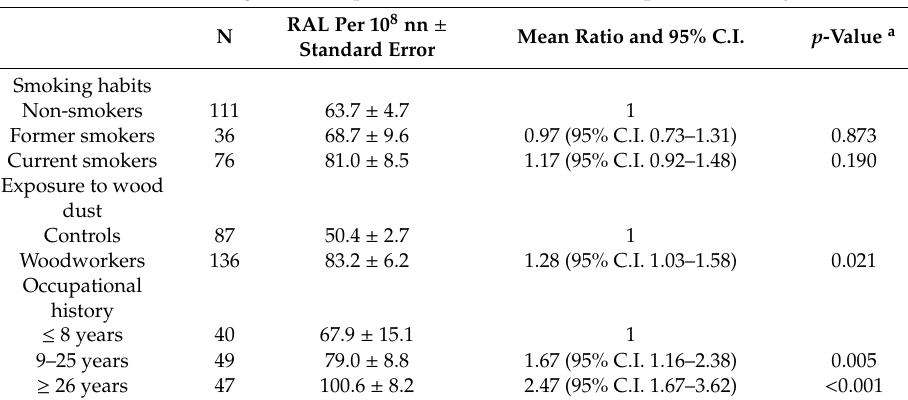
Table 1. Mean level of three-(2-deoxy- β -D-erythro-pentafuranosyl)pyrimido[1,2- α ]purin-10(3H)-one deoxyguanosine (M 1 dG) adducts, expressed as a relative adduct level (RAL) per 10 8 normal nucleotides (nn), Mean Ratio (MR), and 95% Confidence Interval (C.I.), by exposure to wood dust and other variables.